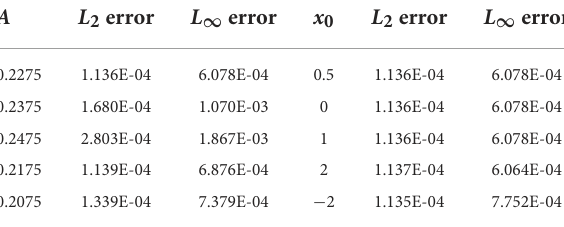
TABLE 2 Errors of the CANN solution for Example 3.2 at T = 1 with different A or x 0